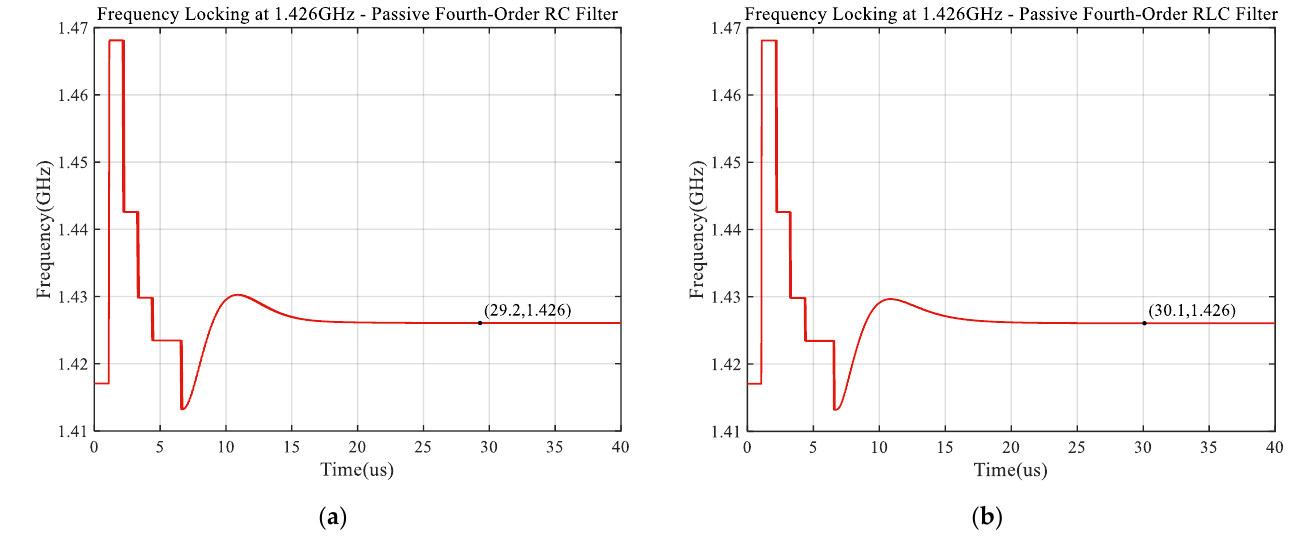
Figure 8. Loop capture time simulation results: ( a ) passive fourth-order RC filter and ( b ) passive fourth-order RLC filter.